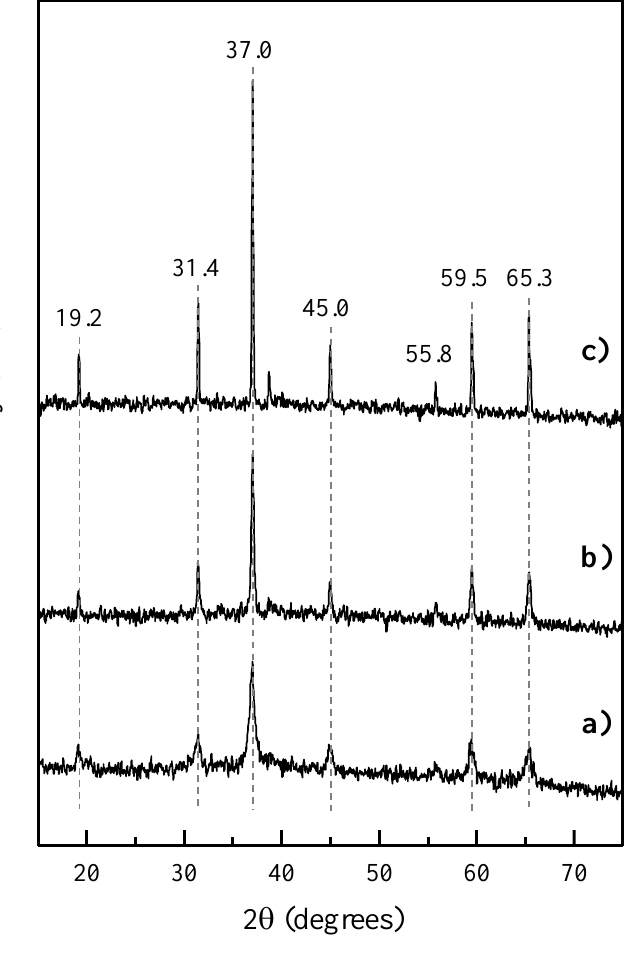
Figure 3. Powder X-ray diffraction (XRD) patterns of Co 3 O 4 -based catalysts activated at different calcination temperature: 300 ( a ), 550 ( b ), and 750 °C ( c ).